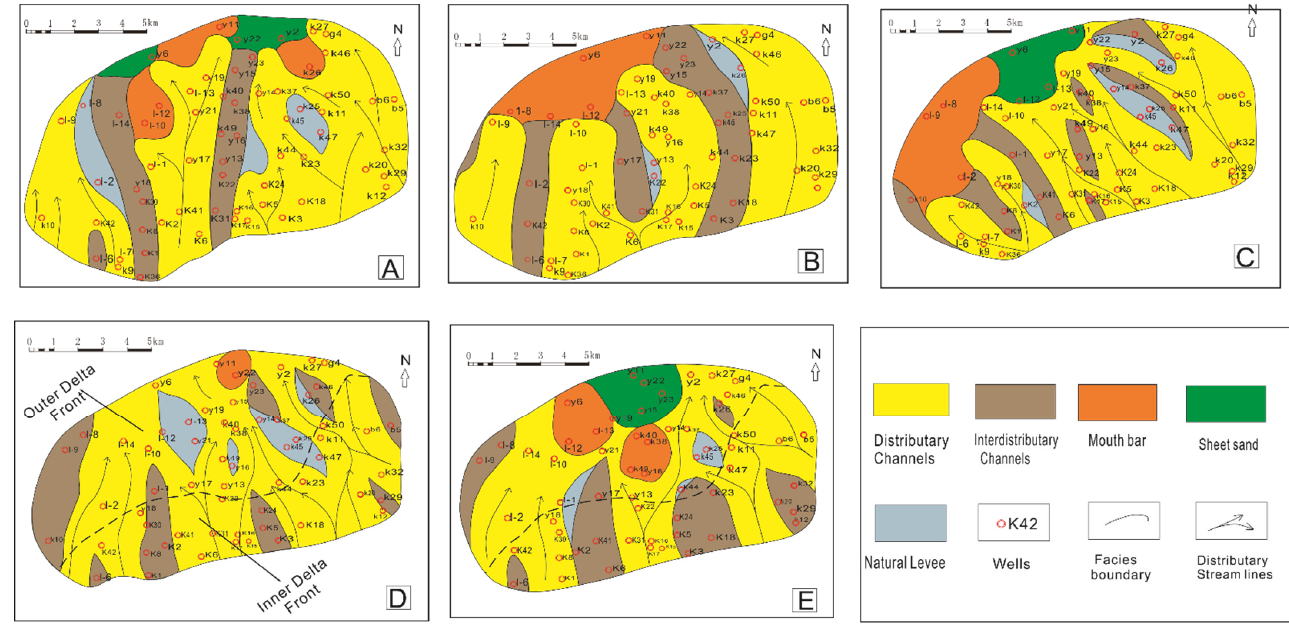
Figure 16. Distribution pattern of Facies associations in five sandstone groups ( A ) Es3z2+3, ( B ) Es3z4, ( C ) Es3z5, ( D ) Es3z6+7, ( E ) Es3z8 in the Bonan Sag. Dotted line marks a zone between outer and inner delta front facies. Interdistributary mudstone of lacustrine origin is found in wells l-8, l-9 of the lower sandstone units (Es3z6+7, Es3z8).